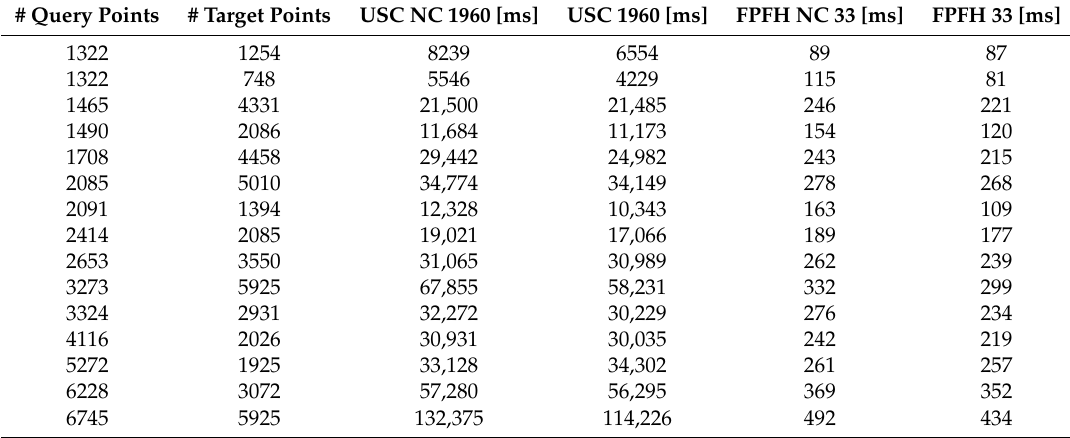
Table 1. Processing time that takes to compute the registration pipeline of Figure